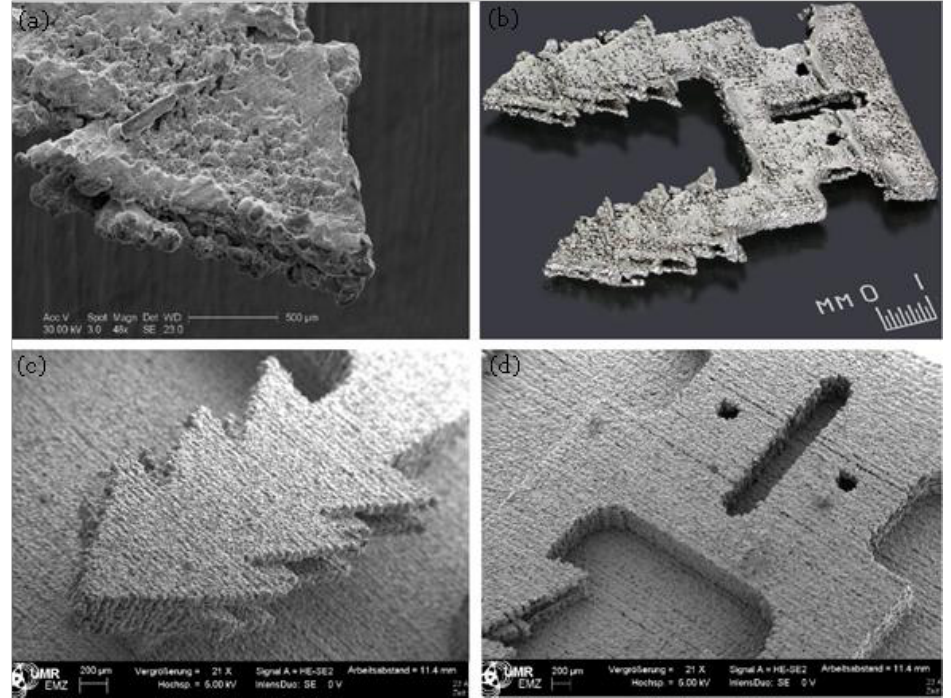
Figure 19. The double enlarged staple (to allow fabrication using beam-based system) printed using ( a , b ) SLM process (source: MICA Freeform vs Selective Laser Melting published by Microfabrica, USA) and ( c , d ) BJ technology (material 316L).